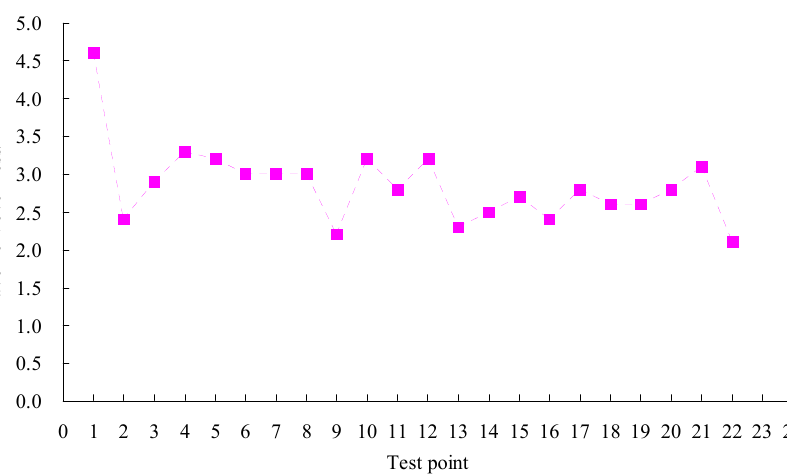
Figure 13. Test results of pavement roughness for test road.